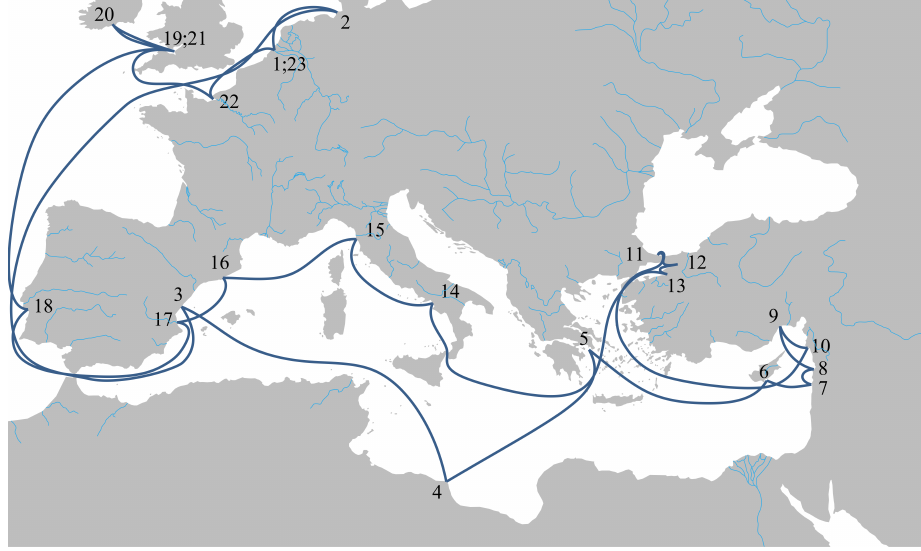
Figure 1. LCTC Considered